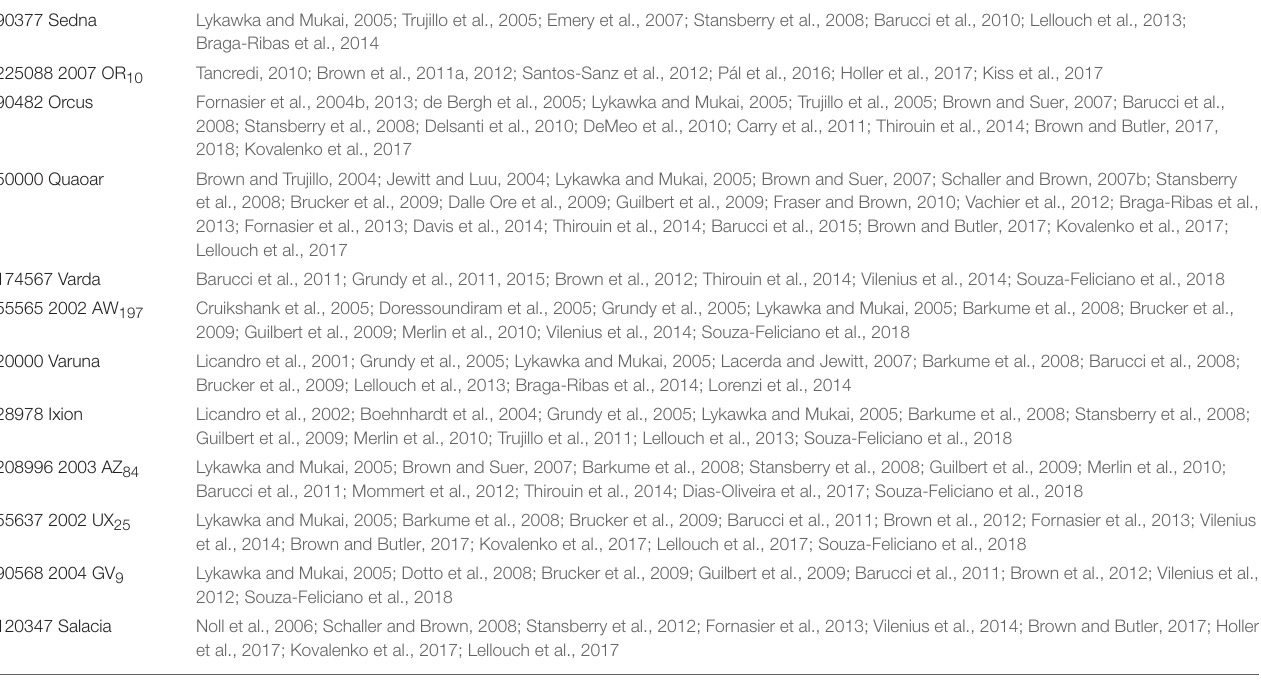
TABLE 3 | References for TNO characteristics given in Table 1